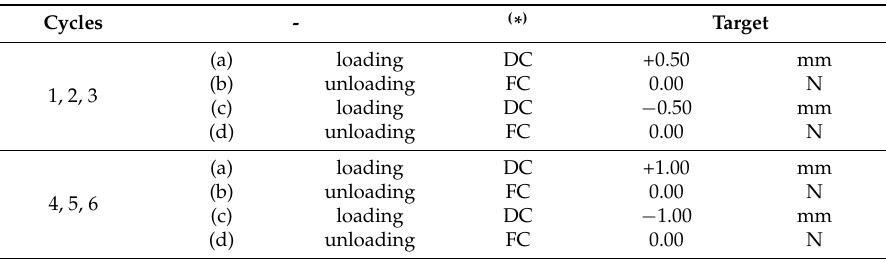
Table 3. Multi-step testing procedure (preliminary tests).